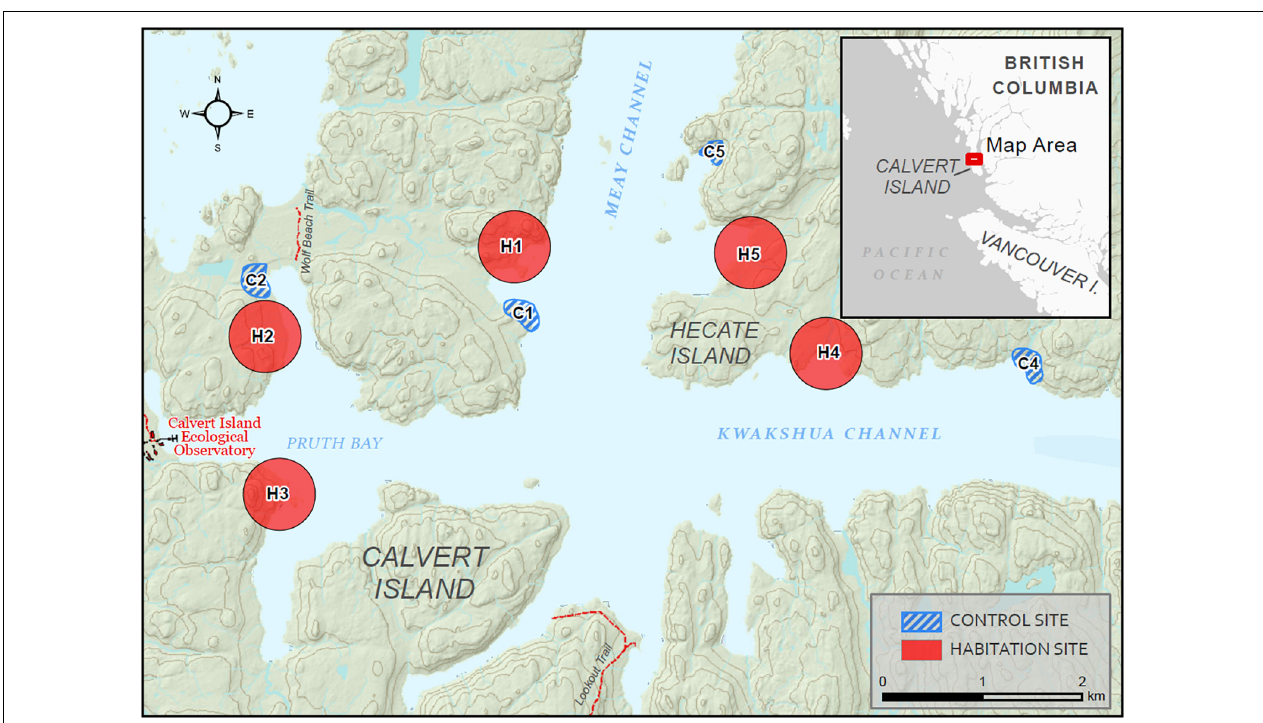
FIGURE 1 | Map of Calvert and Hecate Islands showing habitation (red polygons) and control sites (blue hashed polygons). Red polygons are presented as larger fields as not to disclose specific habitat site locations. Site types are denoted by H, Habitation and C, Control.